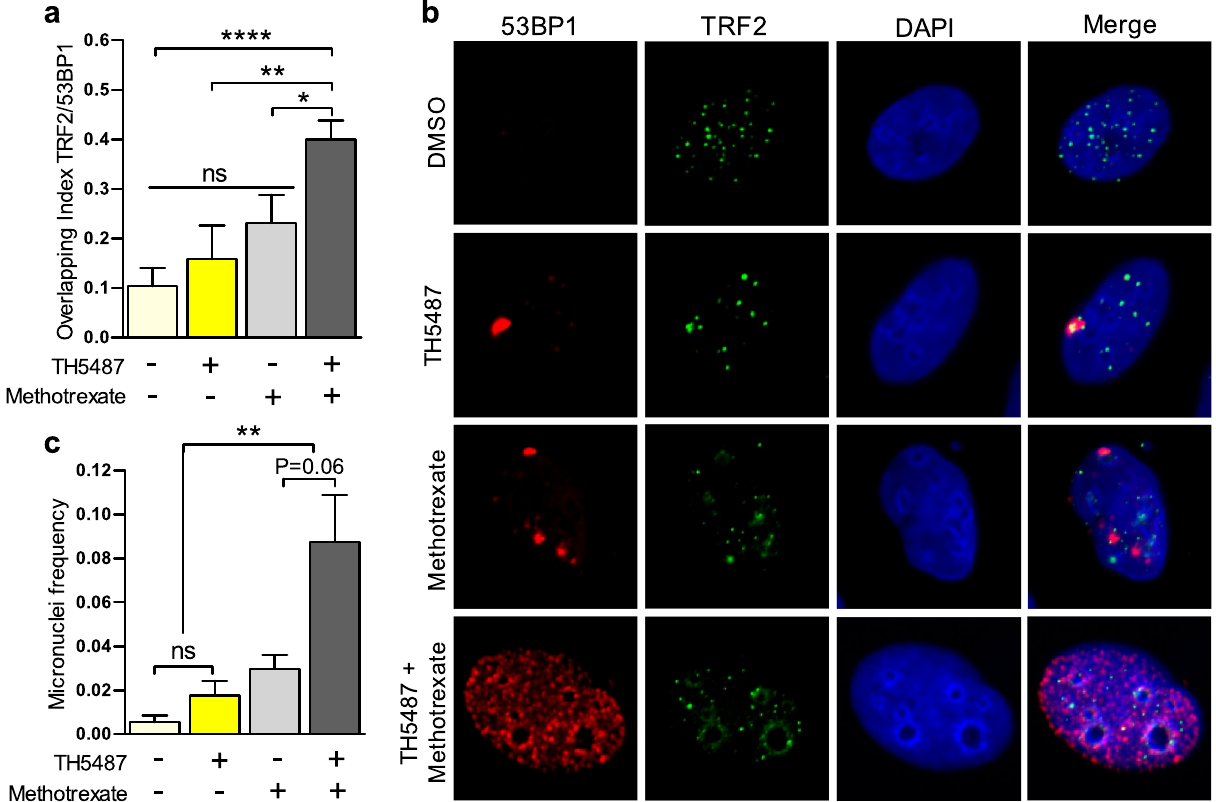
Figure 5. TH5487 synergizes with methotrexate through induction of telomere DNA damage, and genome instability. ( A ) Quantification of 53BP1 signal intensity integrated within telomeres from more than 200 U2OS cells per condition. Data are the average with SEM from 2 independent experiments. Significant differences were calculated using the Mann–Whitney test for non-parametric distributions (**** p < 0.0001 and ns: not significant). ( B ) Confocal imaging at single U2OS cells representative for each treatment condition and stained for 53BP1 (red) and TRF2 (green) using specific antibodies or DAPI to stain cell nucleus (blue). ( C